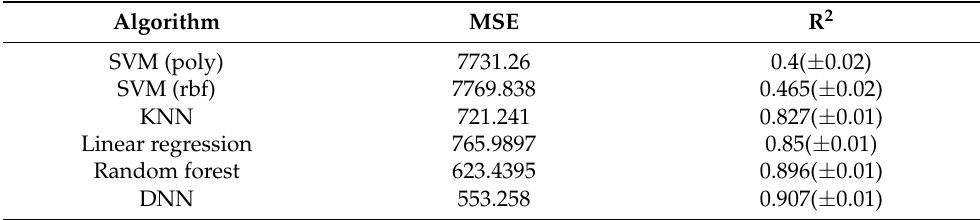
Table 3. Comparison of prediction accuracy of different machine learning algorithms [20].